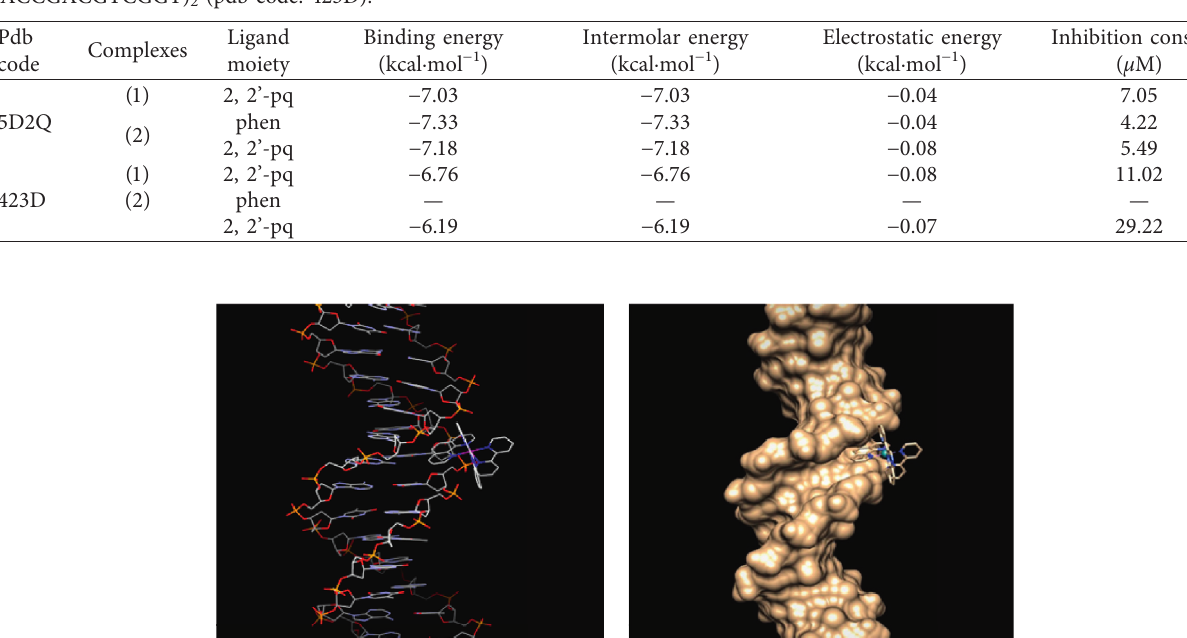
2 (pdb code: 5D2Q) and